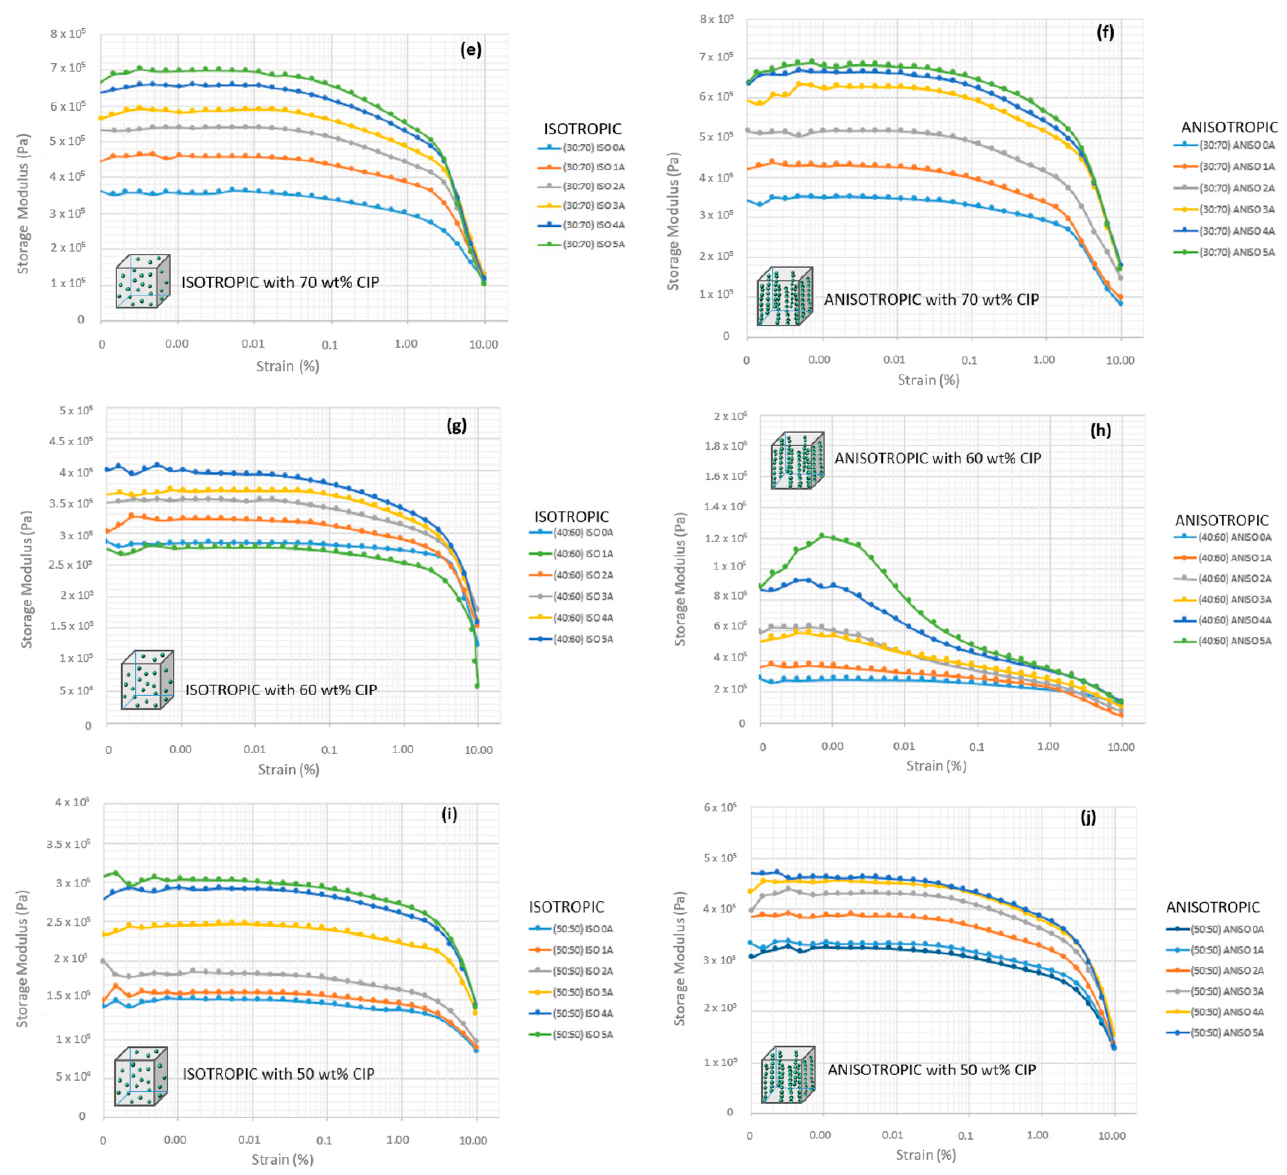
Figure 4. The storage modulus behavior at various microparticles fraction and alignment of ( a ) isotropic (ISO) sample at 80 wt% CIP; ( b ) anisotropic (ANISO) sample at 80 wt% CIP; ( c ) isotropic sample at 75 wt% CIP; ( d ) anisotropic sample at 75 wt% CIP; ( e ) isotropic sample at 70 wt% CIP; ( f ) anisotropic sample at 70 wt% CIP; ( g ) isotropic sample at 60 wt% CIP; ( h ) anisotropic sample at 60 wt% CIP; ( i ) isotropic sample at 50 wt% CIP; and ( j ) anisotropic sample at 50 wt%